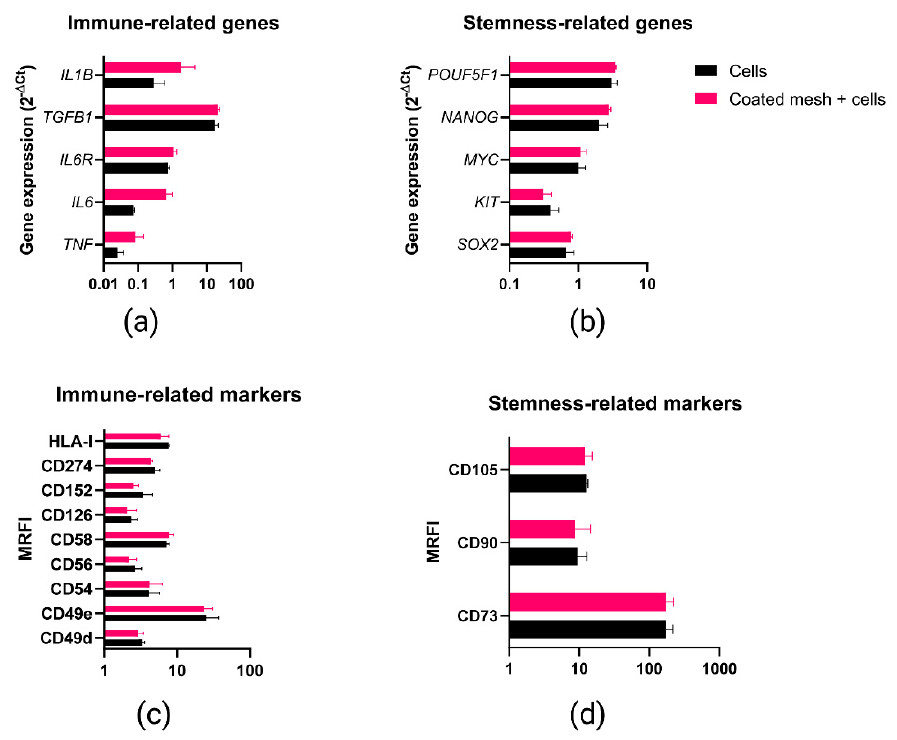
Figure 5. Gene expression and phenotypic marker analyses for Coated mesh + cell vs. Cells group. “Cells” refers to menstrual blood-derived stromal cells (MenSCs) seeded on uncoated PP meshes; “Coated mesh + cells” refers to MenSCs seeded on fibrin-coated PP meshes (bilayered fibrin coating performed with 5 mg/mL fibrinogen + 5.5 IU/mL thrombin solutions in PBS). Immune-related ( a ) and stemness-related ( b ) gene expression was evaluated through quantitative PCR (qPCR) analysis. Likewise, immune-related ( c ) and stemness-related ( d ) surface markers were analyzed through flow cytometry. Mann-Whitney test revealed no statistically significant differences between the two groups. Values along the x-axis are represented in logarithmic scale. MRFI: mean relative fluorescent intensity.